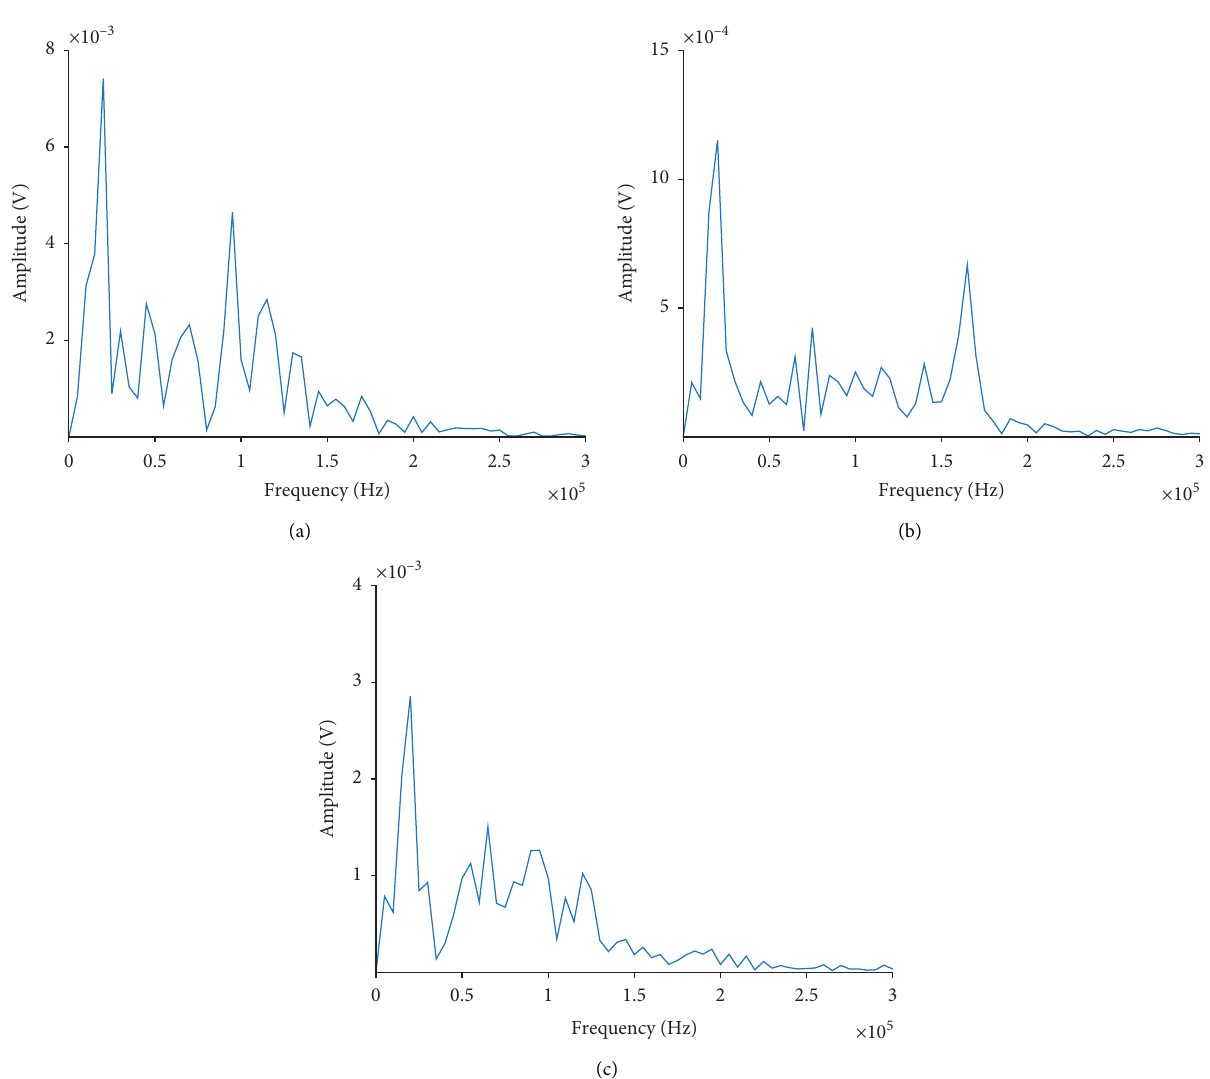
Figure 8: Amplitude–frequency characteristics of ultrasonic wave after rock preloading. (a) Amplitude-frequency characteristics of CH2. (b) Amplitude-frequency characteristics of CH3. (c) Amplitude-frequency characteristics of